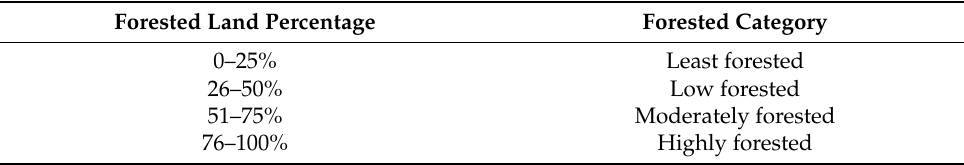
Table A1. Categories of how forested each HUC8 in the data set was sorted